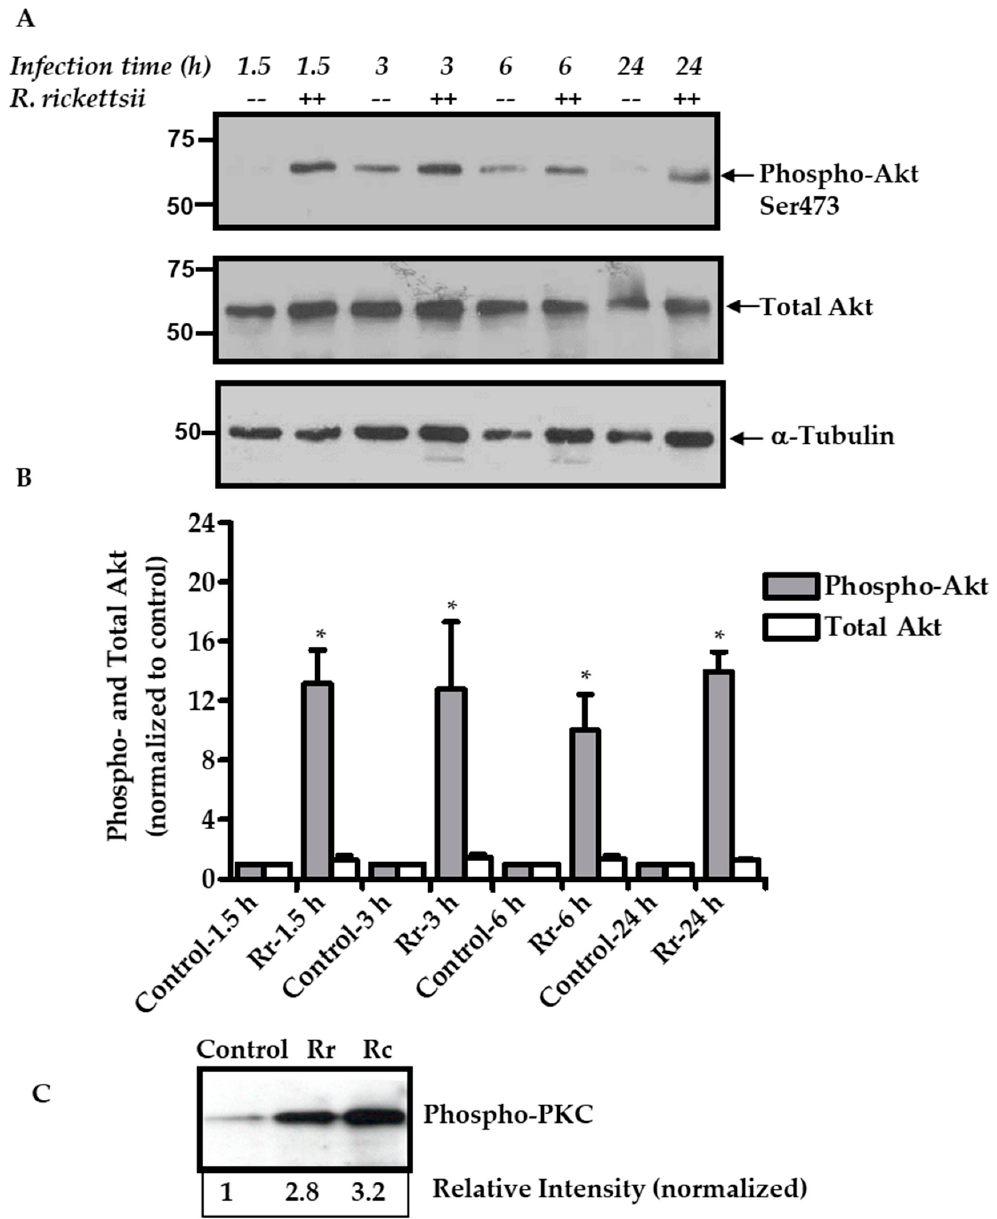
Figure 2. Mechanistic target of rapamycin complex 2 (mTORC2) activation in R. rickettsii -infected ECs. ( A ). Confluent monolayers of human microvascular endothelial cells (HMECs) were either